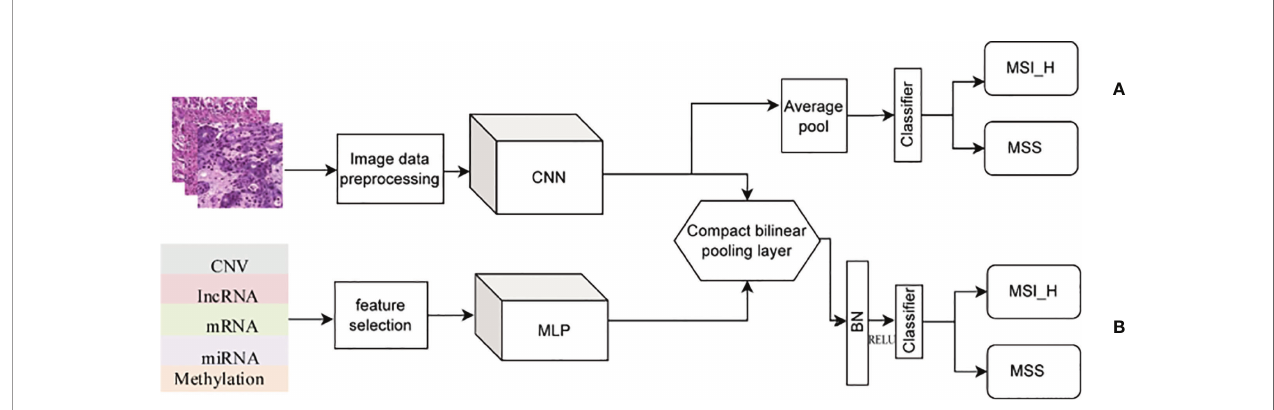
FIGURE 2 | Experimental fl owchart. (A) Only H&E images data. (B) H&E images combined with multi-omics